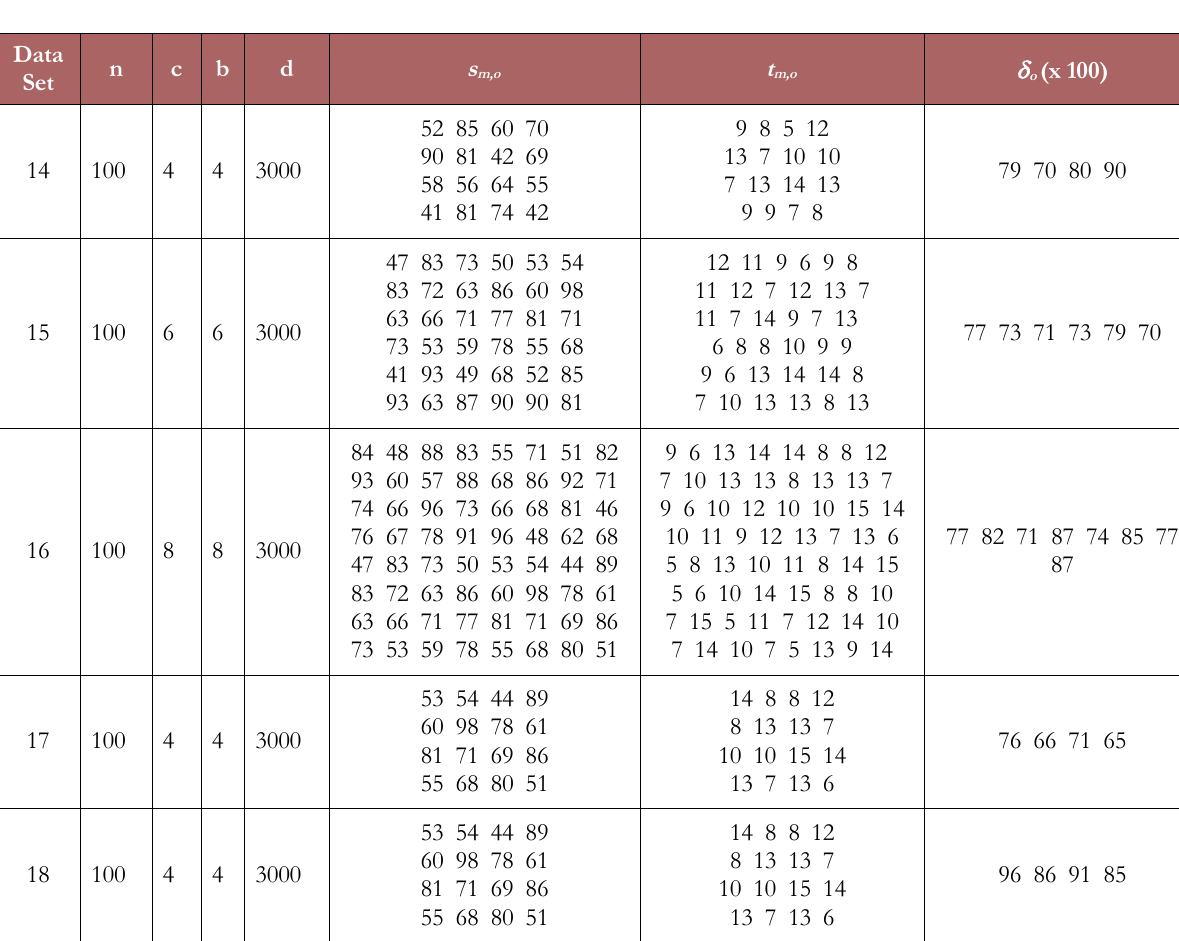
Table 1. Parameter of data